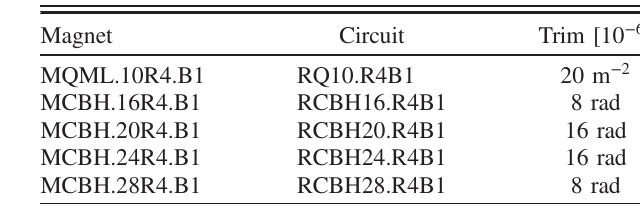
TABLE III. Trim settings implemented to correct arc 45 at β (cid:1) ¼ 60 = 15 cm. It combines a trim on the Q10 on the right side of IR4 (MQML.10R4.B1) with an orbit bump created using the dipoles shown in the table (MCBH) that peaks in the main sextupoles MS.18R4.B1, MS.22R4.B1 and MS.26R4.B1 reach- ing 1.5 mm.